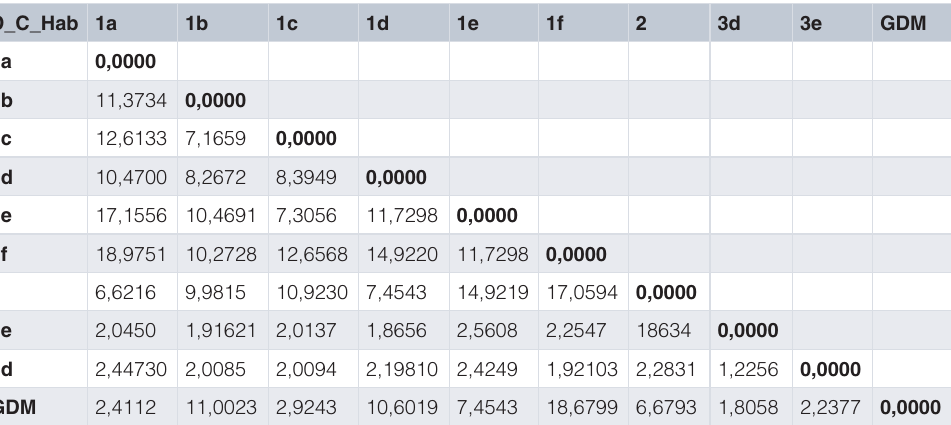
Table 6. Euclidean distance using the overlap operator in Equation